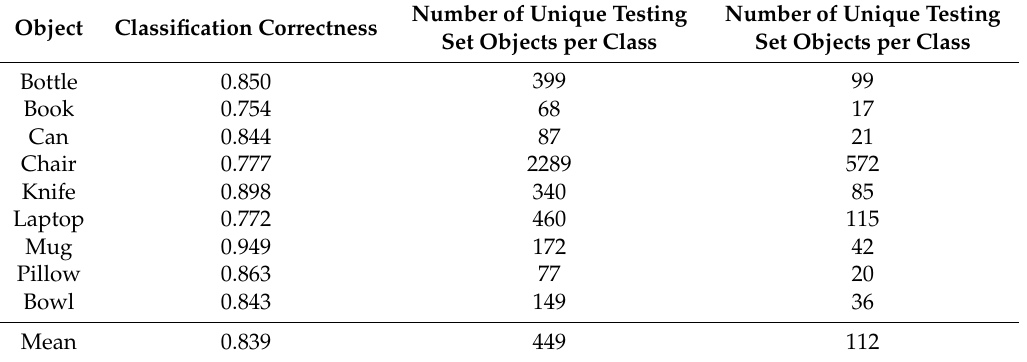
Table 1. Quantitative results of classifier recall rate on testing set. Our entire dataset was split using 80:20 rule into training and validation